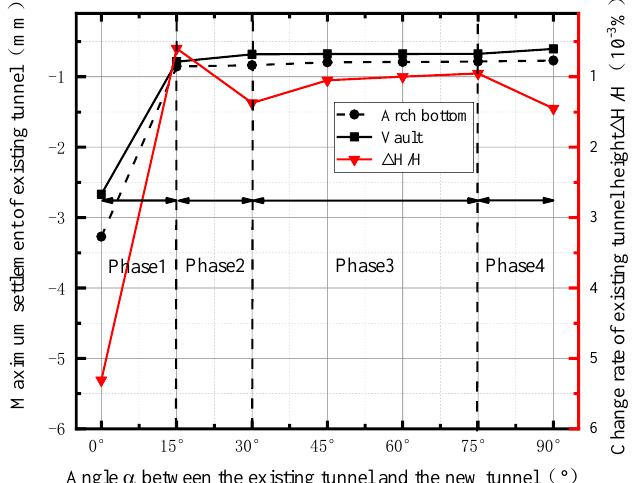
Figure 20. Maximum settlement and height change rate of the existing tunnel under different spatial intersection angles.